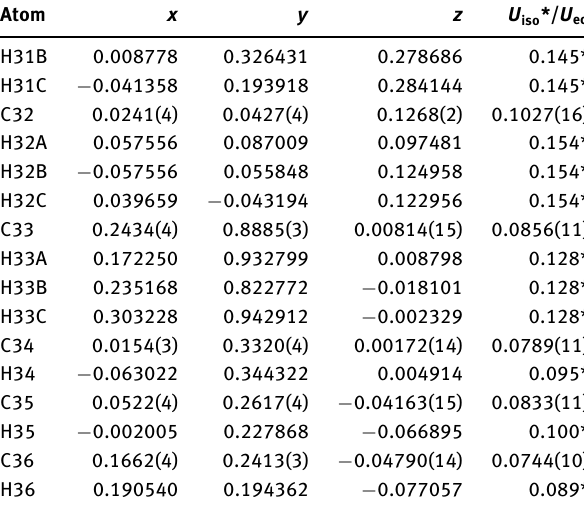
Table 2: Fractional atomic coordinates and isotropic or equivalent isotropic displacement parameters (Å 2